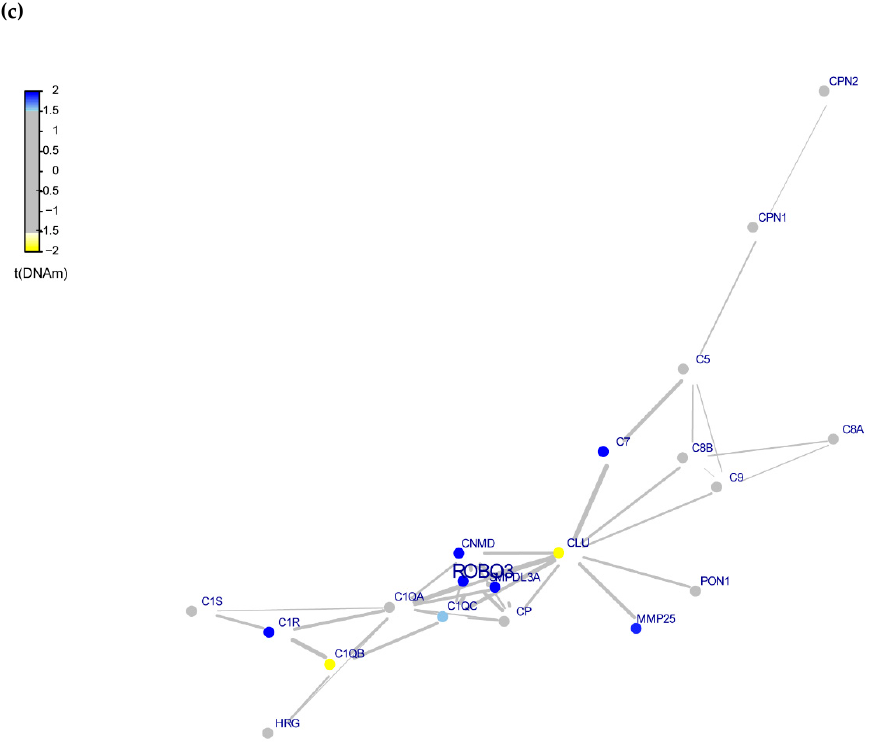
Figure 3. The functional epigenetic module of seed gene. ( a ) Module (BCL2A1), ( b ) Module (UNC19), and ( c ) ROBO3. Each dot is a gene and edges are the interaction in the PPI network, colors represent hypermethylation (blue) and hypomethylation (yellow) CpG sites in group B compared to group A samples. Gray dots are genes that showed no statistical significance in the comparison between groups or not represented in the initial analysis.